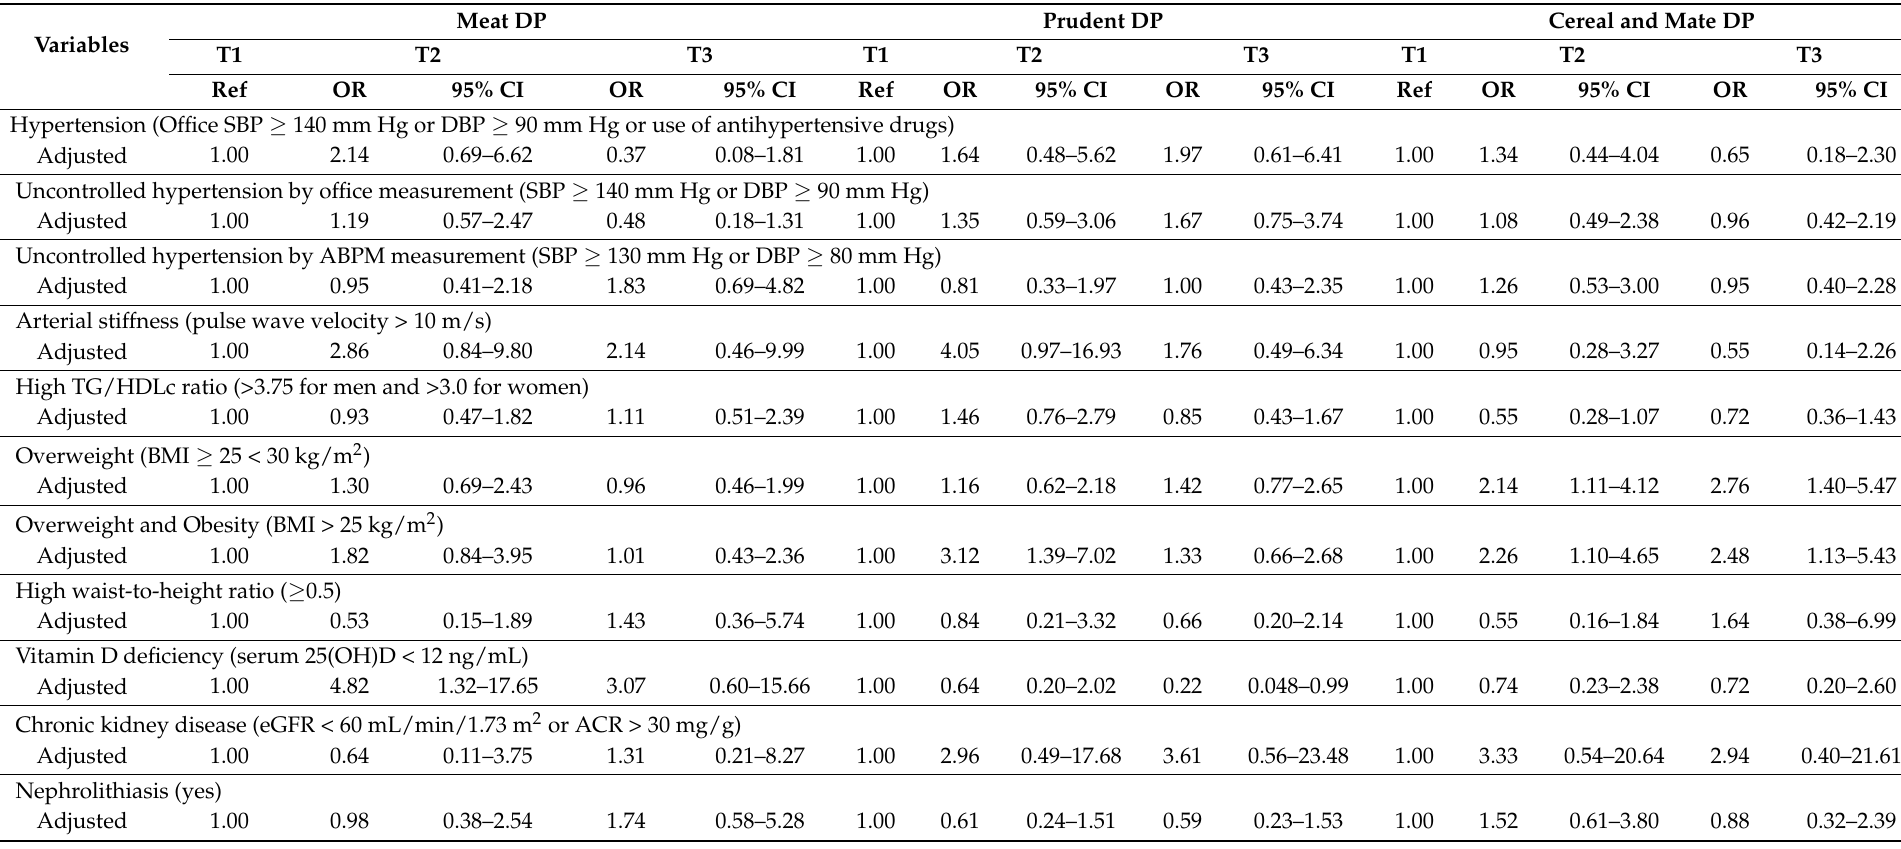
Table 5. General adjusted odds ratio (OR), 95% confidence intervals (CI) for cardiovascular and renal risk phenotypes according to tertiles (T) of dietary patterns in Uruguayan adults.